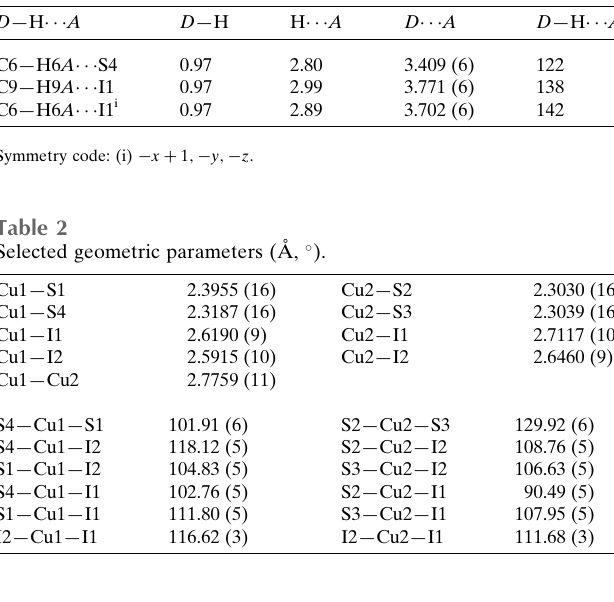
Table 1 Hydrogen-bond geometry (A˚ , (cid:5) ).